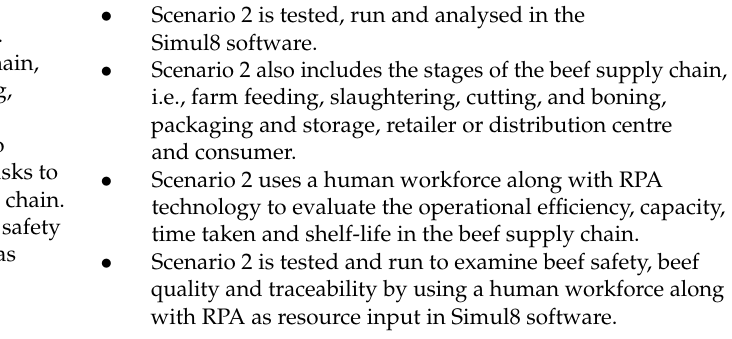
Table 2. Scenario 1 and scenario 2 overview.